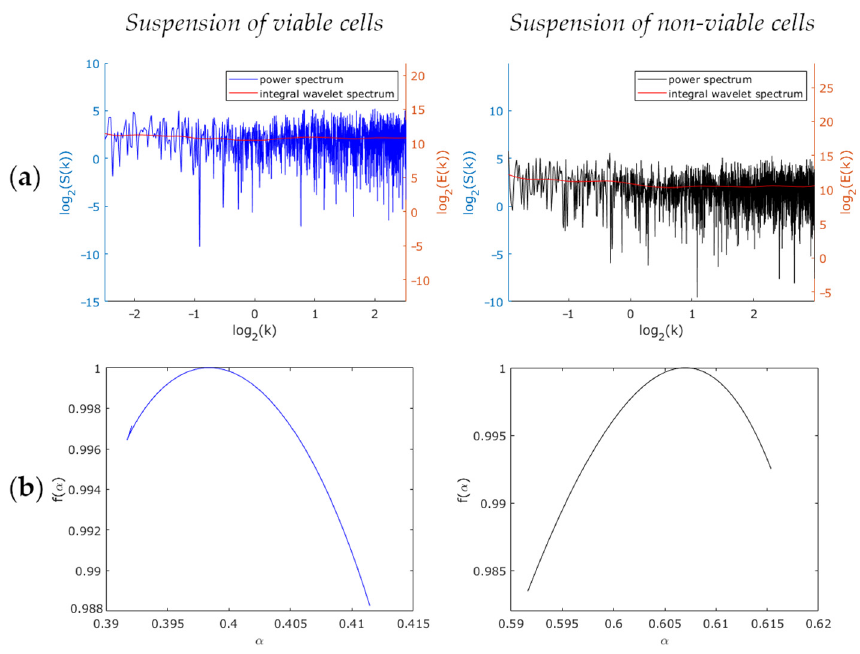
Figure 6. Comparison of viable and non-viable suspended cells: ( a ) Power spectrum and integral wavelet spectrum; ( b ) Multifractal spectra.